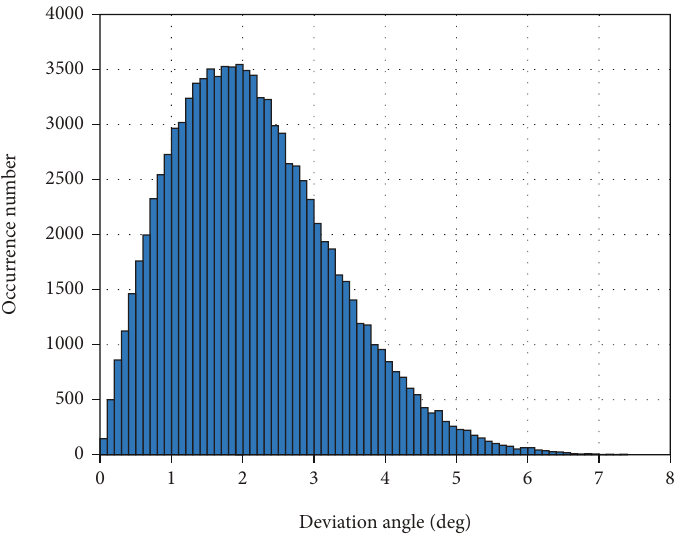
Figure 4: Statistical histogram of the angles that the available navigation stars deviate from the optimal navigation star.